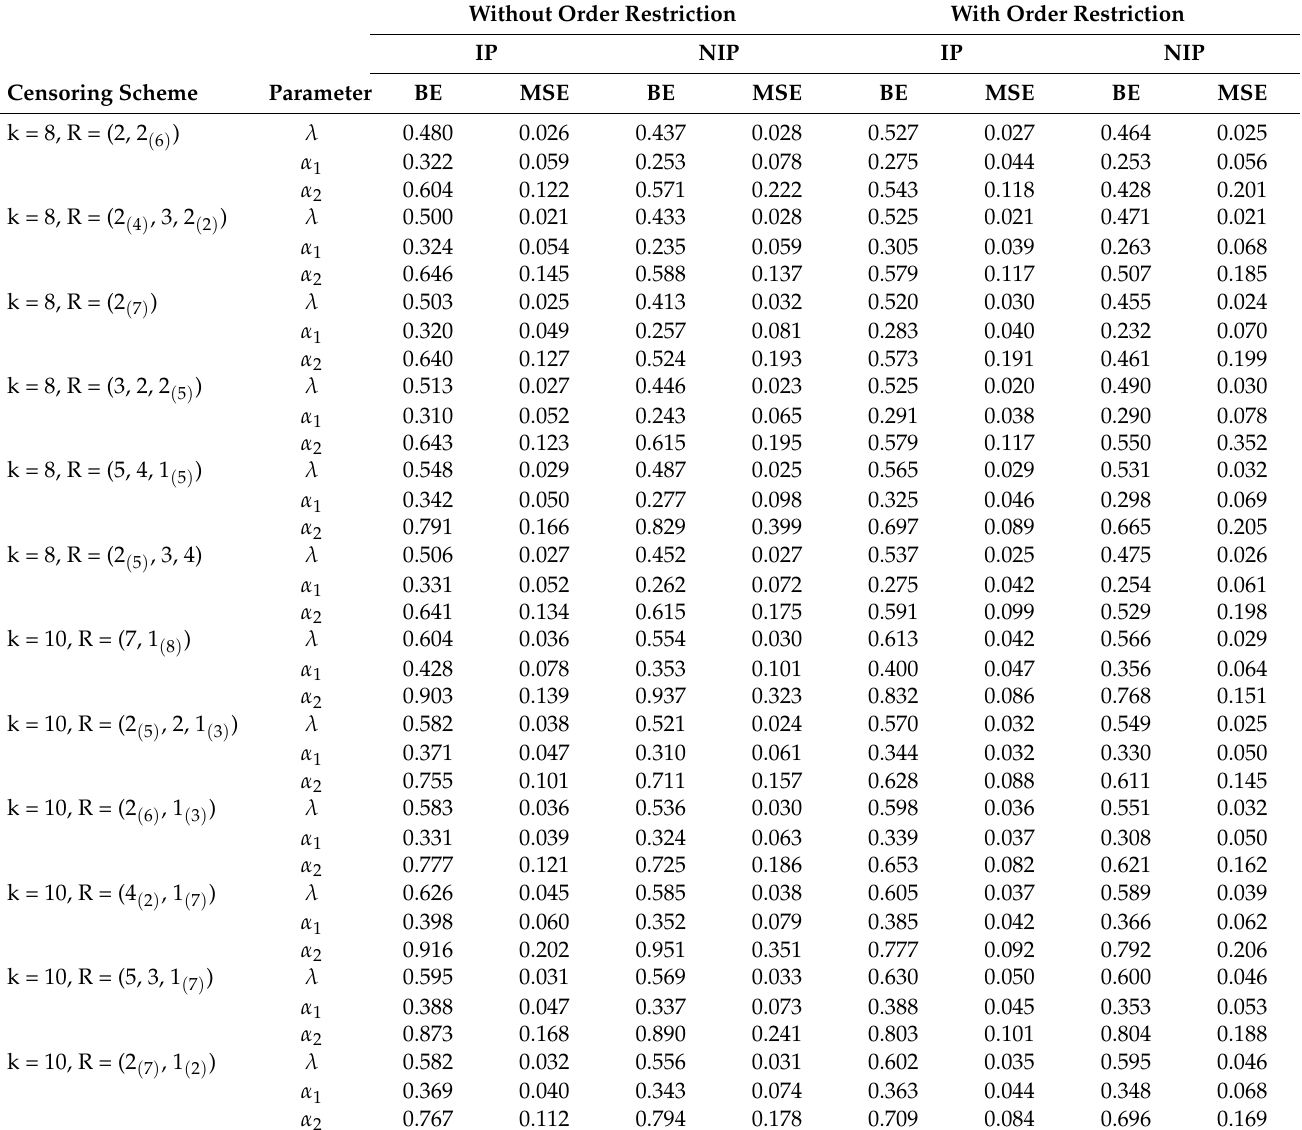
Table 6. MSEs and BEs of the Bayesian estimates of the model parameters with λ = 0.5, α 1 = 0.4, and α 2 = 0.8 based on the importance sampling procedure and different